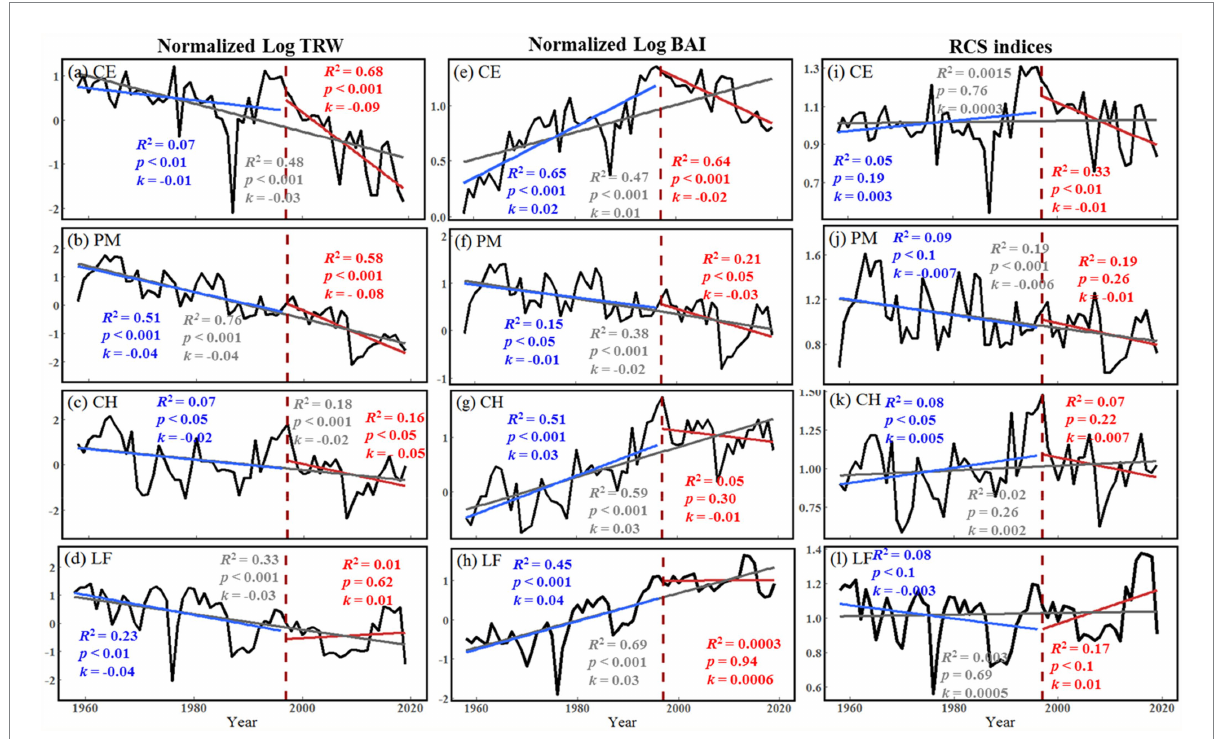
FIGURE 5 Long-term trends of tree growth (Normalized Log TRW, Normalized Log BAI, and RCS indices) during 1958–1996 (blue), 1997–2019 (red) and 1958–2019 (grey) at the northern Luoxiao Mountain. (a, e, i) CE = C. eyrei , (b, f, j) PM = P. massoniana , (c, g, k) CH = C. henryi and (d, h, l) LF = L. formosana . The R -squared, the slope ( k ) and value of p of each model are listed in the